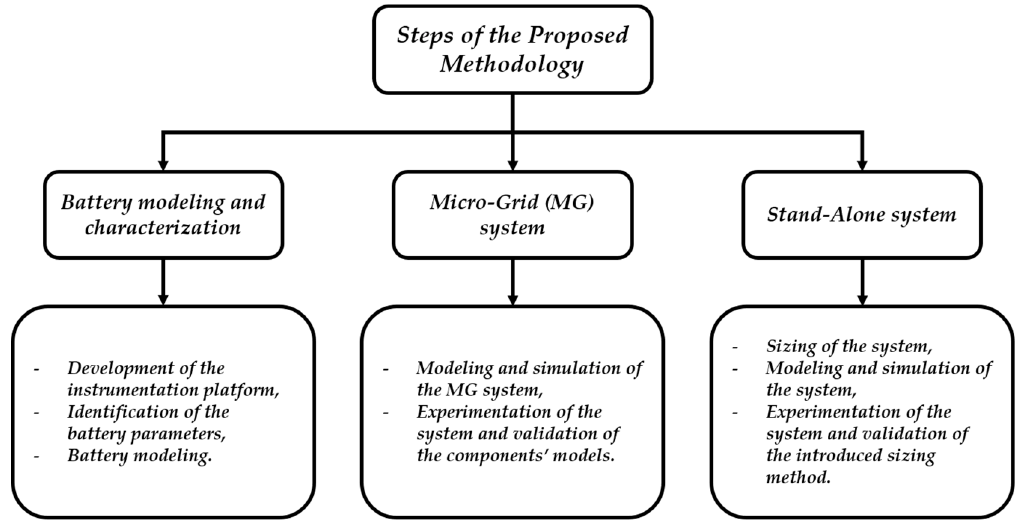
Figure 1. Steps of the proposed methodology.